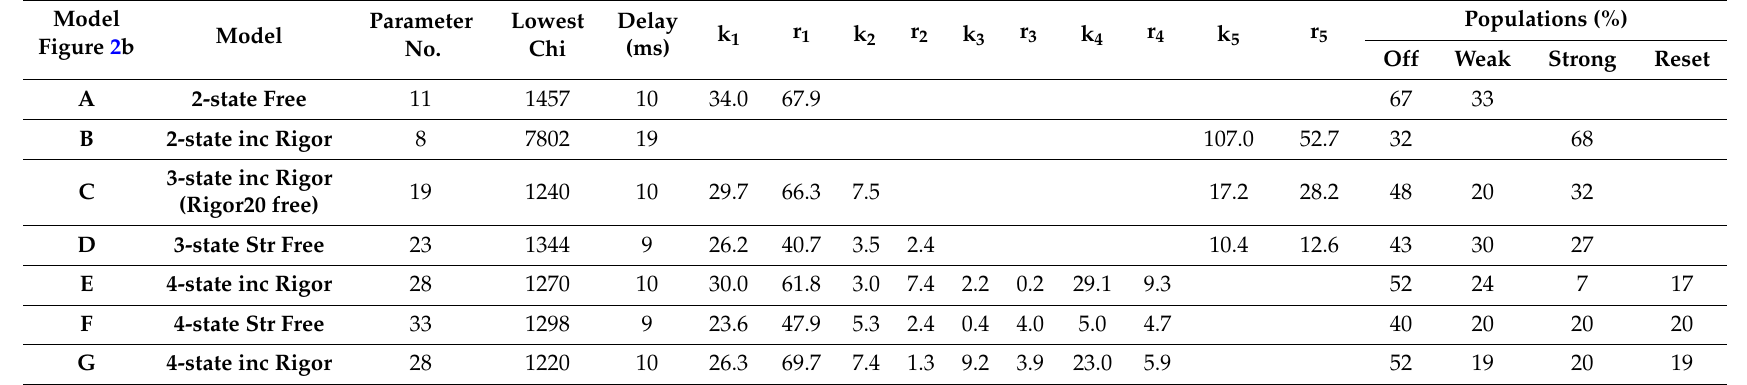
Table 4. Results on the rate constants and state populations from the equatorial modelling for the cycles shown in Figure 2b. The best time-resolved values for all combinations are shown. Chi has an arbitrary scaling. Where “inc Rigor” is used it indicates the strong state used was the rigor state. “Rigor 20 free” indicates that all rigor reflections except the A(20) were allocated their observed values, whereas the A(20) was allowed to change between specified limits. r 6 and k 6 in Figure 2a were zero for these particular